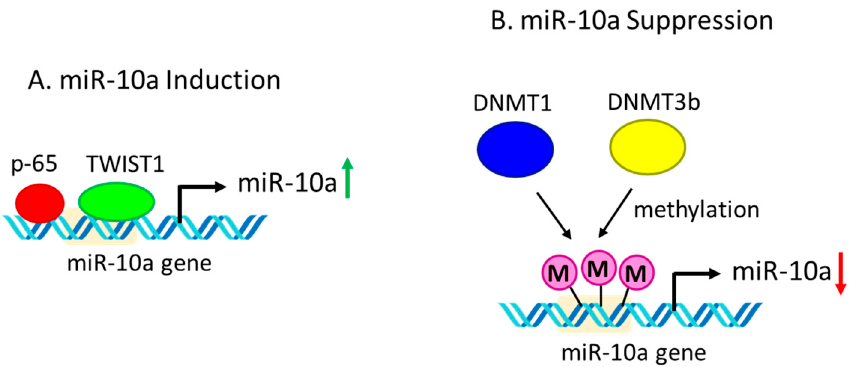
Figure 4. Regulation of miR-10a expression. ( A ) miR-10a induction. Transcription factors p65 and TWIST1 bind to the promoter region of the miR-10a gene resulting in the induction of miR-10a ex- pression. ( B ) miR-10a suppression. DNA methyltransferases DNMT1 and DNMT3b cause promoter methylation of the miR-10a gene resulting in the down-regulation of miR-10a